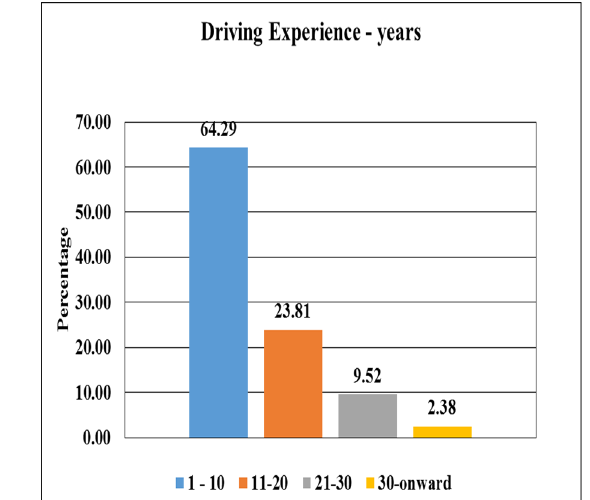
FIG. 3. DRIVING EXPERIENCE OF VEHICLE OWNERS AND DRIVERS